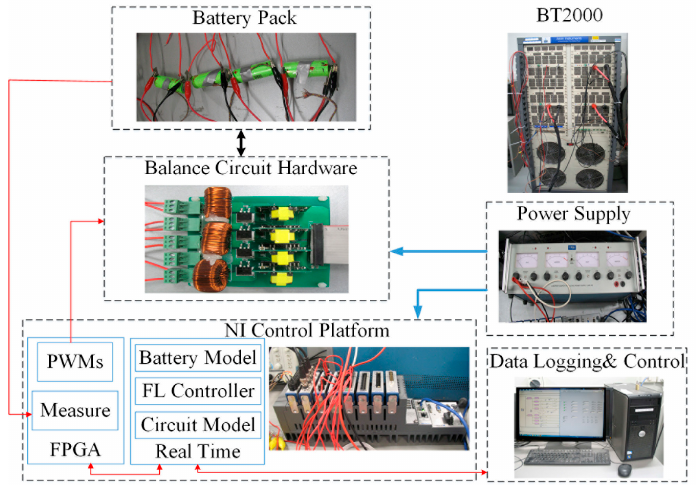
Figure 13. Performance evaluation platform for MSIBC.